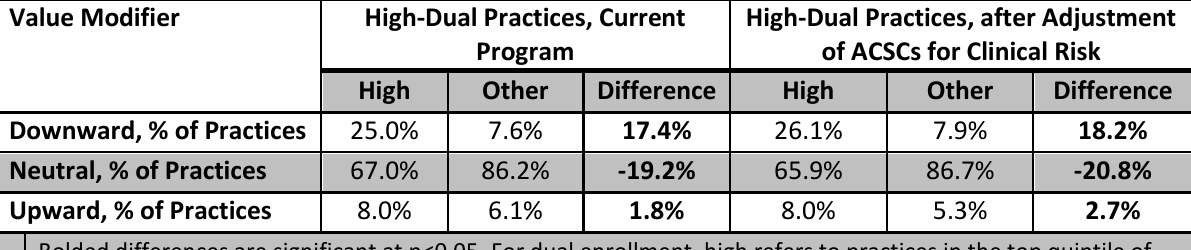
Table 10.19a. Impact on High-Dual Practices of Adjusting ACSCs for Clinical Risk Value Modifier